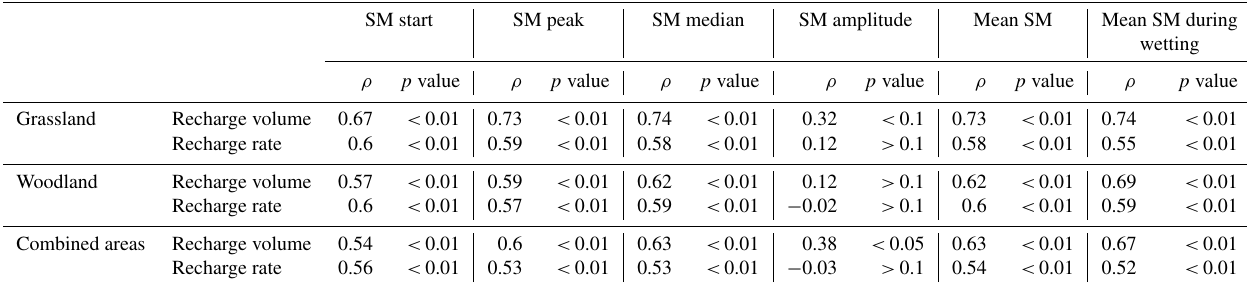
Figure 5. (a) Average number of precipitation (P) events, soil moisture (SM) events, and recharge (R) events selected for each hydrological year. Each orange bar corresponds to one soil profile. (b) Percentage of precipitation events attributed to soil moisture and recharge events with the attribution method (number total of precipitation events = 455). Table 2. Spearman rank correlation ( ρ ) between soil moisture (SM) metrics and recharge descriptors for grassland, woodland, and the combined